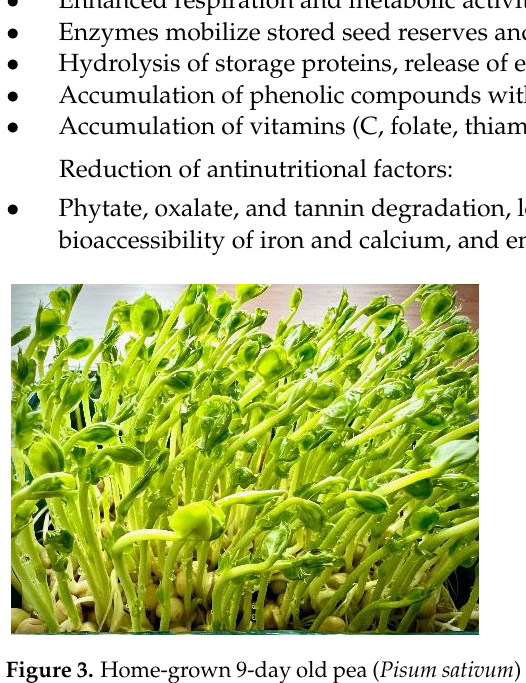
Figure 3. Home-grown 9-day old pea ( Pisum sativum ) microgreens. Commonly recognized nutri- tional benefits of microgreens: •